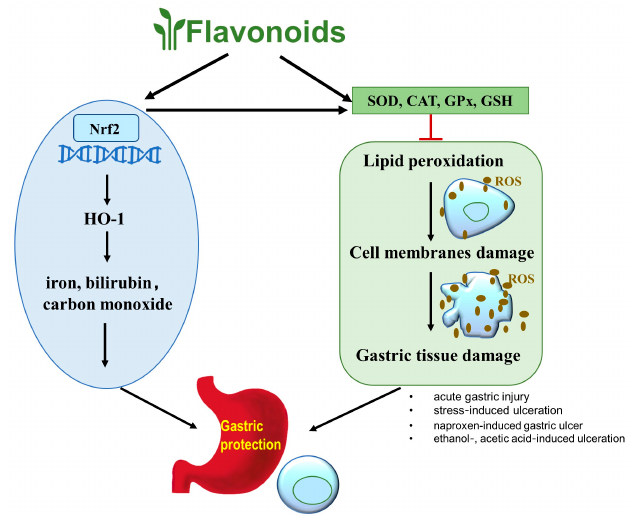
Figure 4. Flavonoids have beneficial effects on treating peptic ulcer via antioxidative activity. Flavonoids increase the activities of antioxidant enzymes, such as superoxide dismutase (SOD), catalase (CAT), glutathione peroxidase (GPx), and glutathione (GSH). and the nuclear Nrf2 level to exert gastroprotective effects through scavenging reactive oxygen species (ROS) and up-regulating the phase II detoxification and antioxidant genes HO-1.2.4 Flavonoids ameliorate peptic ulcer by regulating inflammatory pathways.